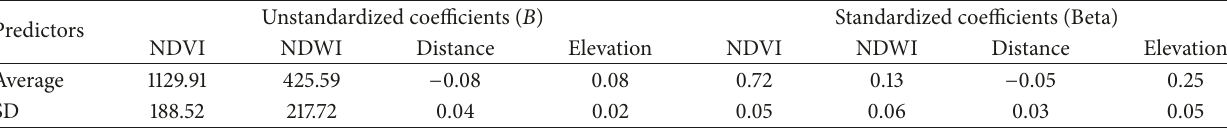
Table 2: Summary of standardized and unstandardized coefficients for different